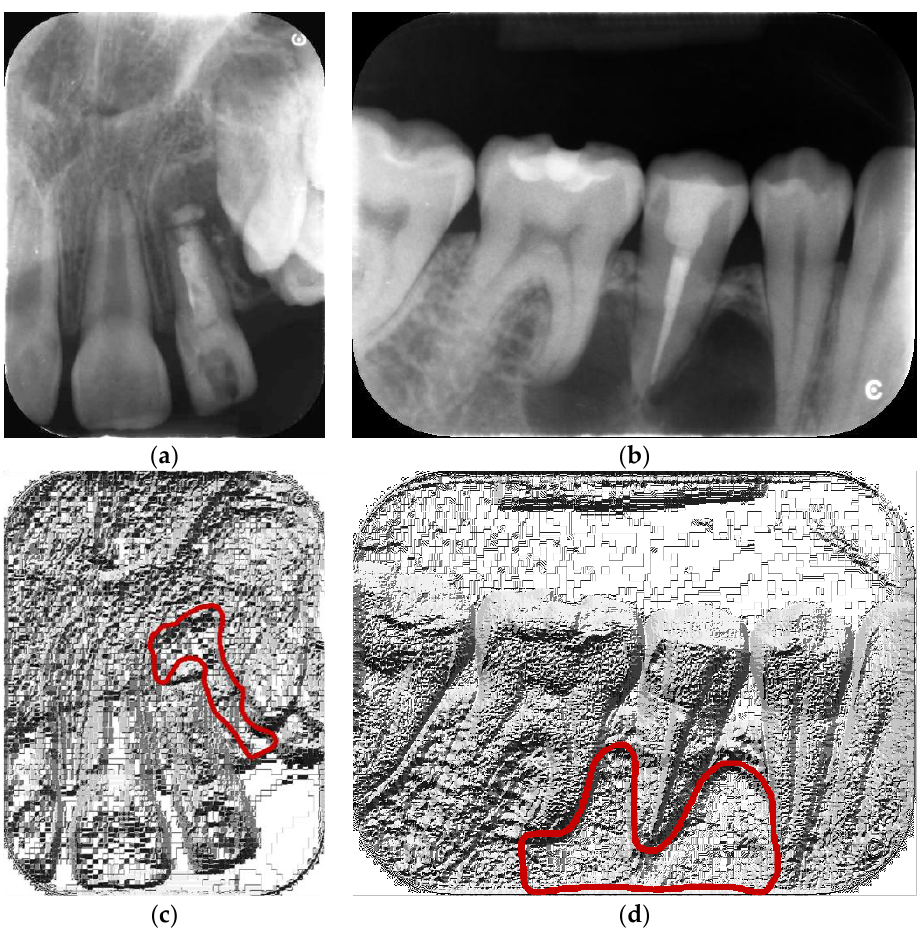
Figure 1. Example of lossy compression artifacts on local binary pattern (LBP) feature maps ( c , d ) calculated for analyzed JPG images ( a,b ). Lesions are depicted with red lines.